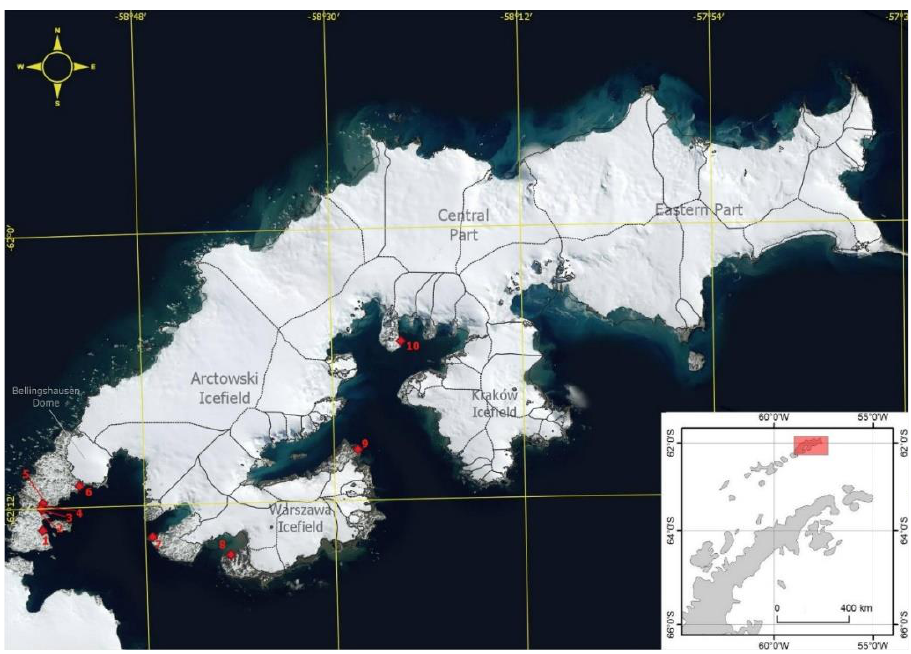
Figure 1. Borders of the glaciers located on KGI and the locations of the following year-round re-